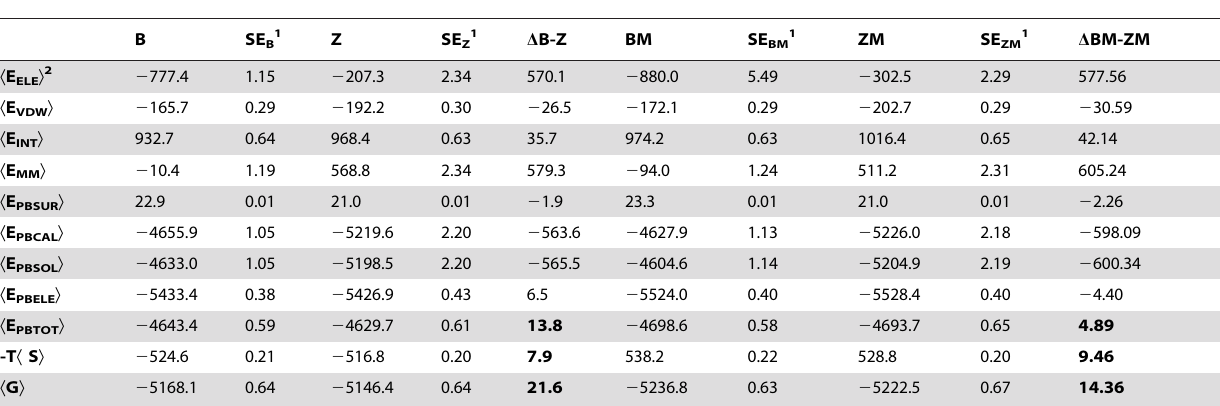
Table 1. MM/PBSA analysis of B, methylated B (BM), Z and methylated Z (ZM)